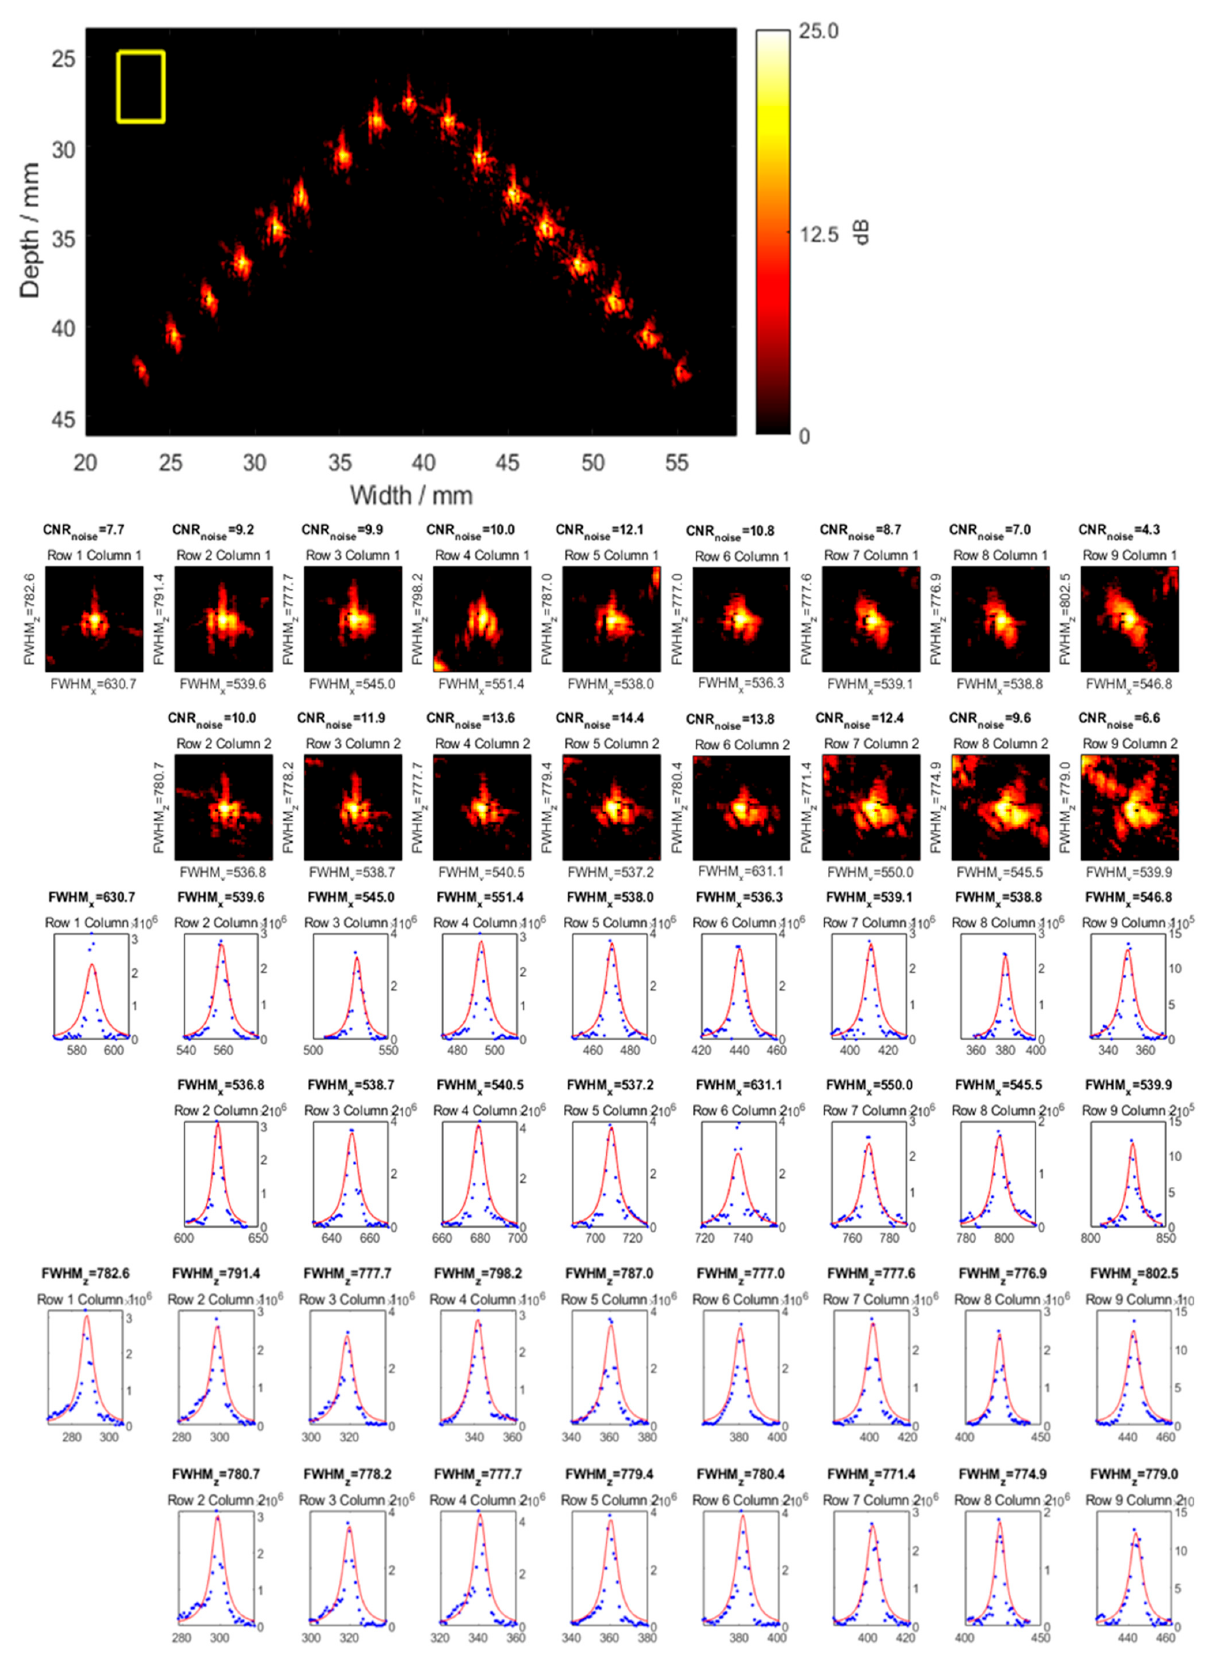
Figure A1. CNR, FWHMx, and FWHMz calculated for each of the 17 points in the multi-point